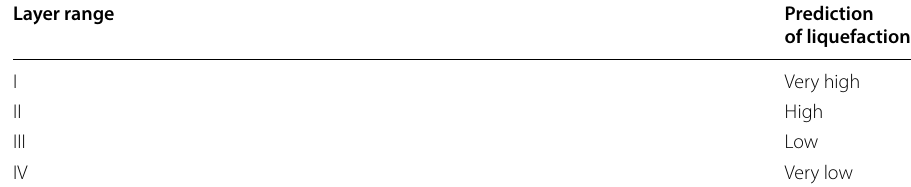
Table 5 Prediction of liquefaction according to OCDI [9]